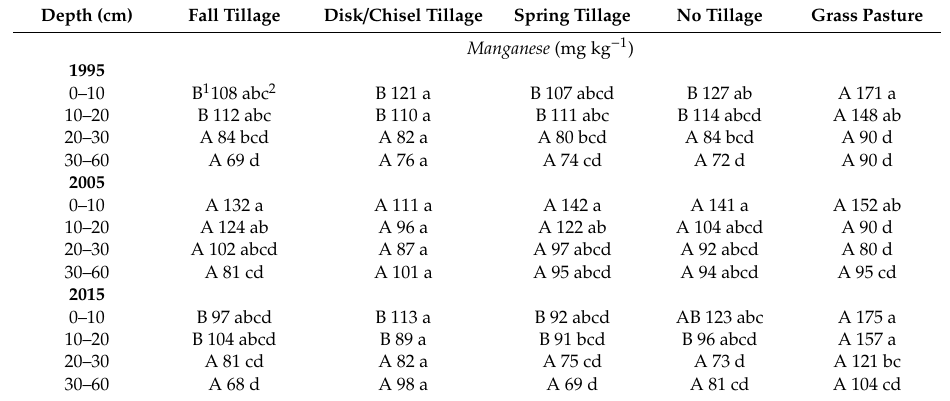
Table 3. Mean concentration of Mehlich III extractable manganese obtained from the combinations of treatment, year, and soil depth in the wheat–pea rotation long-term experiment (WP-LTE) at Pendleton. Depth (cm) Fall